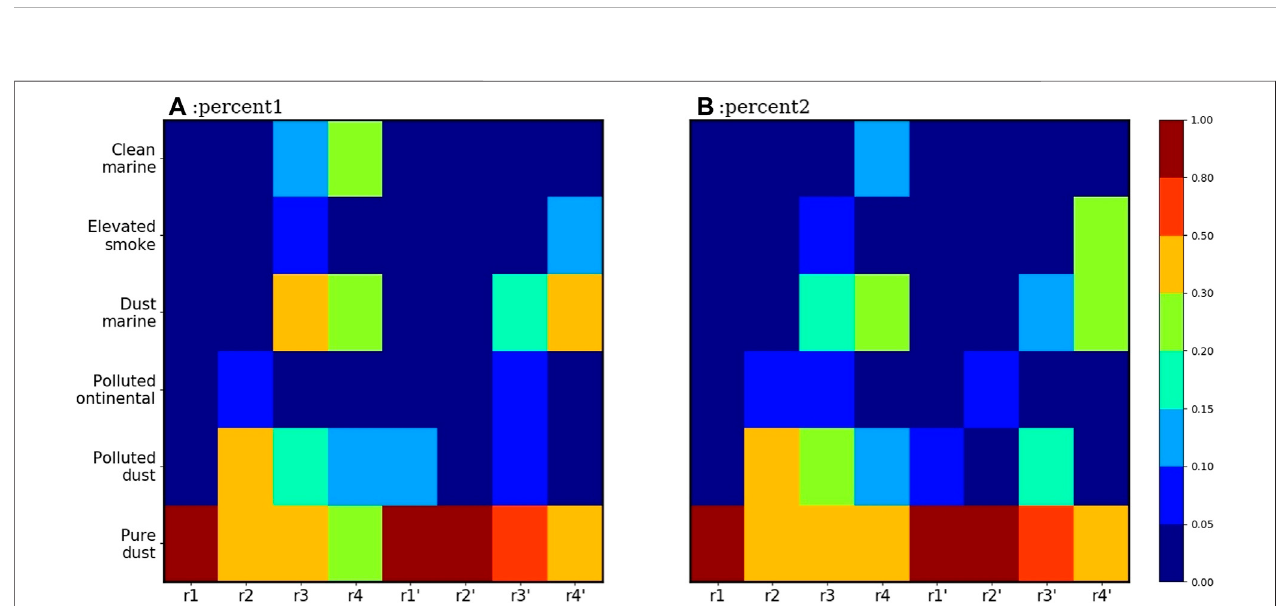
FIGURE 12 | The changes in the percent of different types of aerosols calculated by grid numbers (percent1) and AOD values (percent2) on March 10th, 12th to 14th in 2018 (r1, r2, r3, r4), March 18th to 21st in 2020 (r1 ′ , r2 ′ , r3 ′ , r4 ′ ).